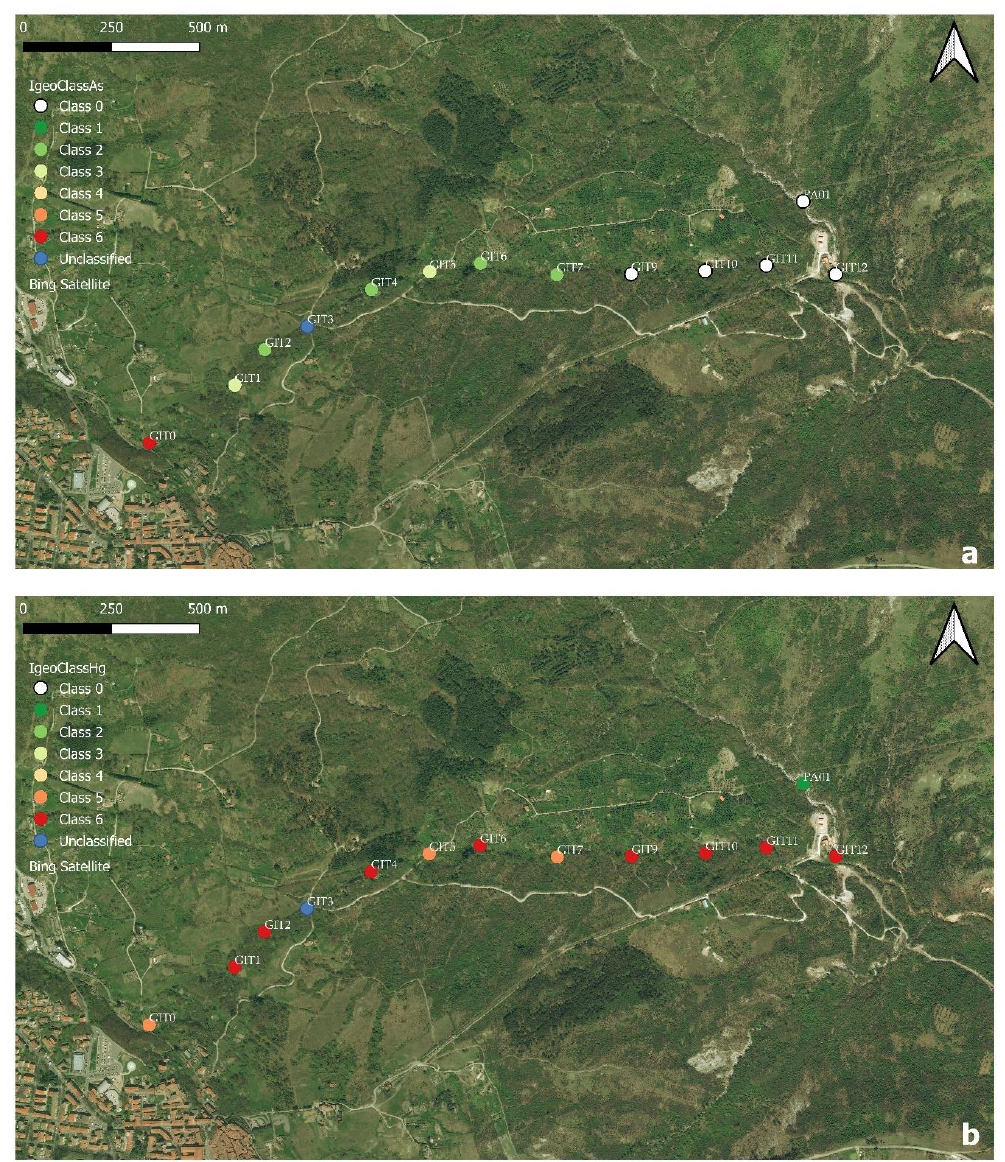
Figure 5. Sampling sites and I geo classes [19] along FdC: ( a ) Arsenic and ( b ) Mercury. The eastern- most portion of Abbadia San Salvatore and the location of PA01, corresponding to the Pagliola creek before the confluence of the FdC creek, are visible in the lower left and upper right corners, respec- tively. The two maps were created with QGIS using Bing Satellite as the base-layer. Legend (accord- ing to [19,28]): Class 0 = “uncontaminated”; Class 1 = “from uncontaminated to moderately contam- inated”; Class 2 = “moderately contaminated”; Class 3 = “from moderately contaminated to heavily contaminated”; Class 4 = “heavily contaminated”; Class 5 = “from heavily to extremely contaminated”; Class 6 = “ Extremely contaminated ” . Sample GIT3 was reported in blue, since no data were available.